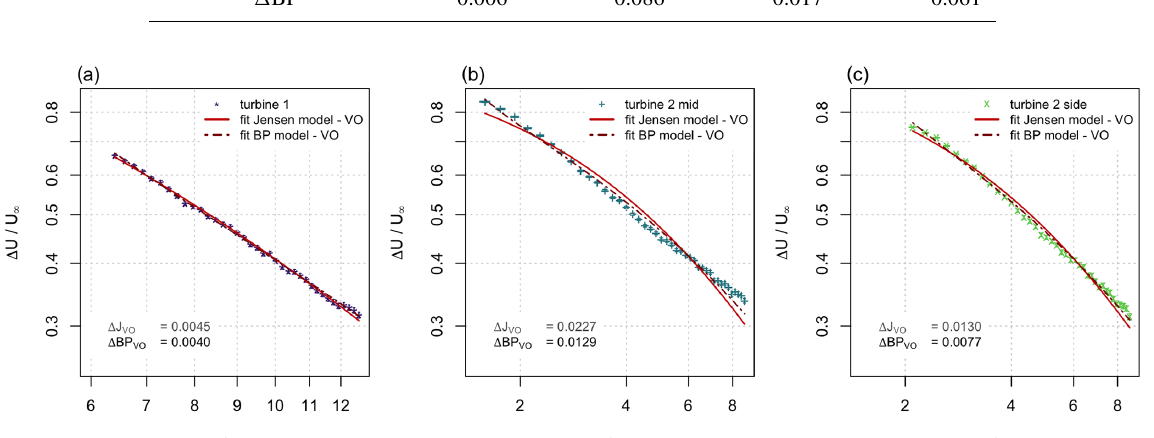
Figure 14. (cid:49)U/U ∞ for the three different inflow conditions at the centerline: (a) turbine 1 – laminar inflow, (b) turbine 2 mid – turbulent, and (c) turbine 2 side – turbulent and intermittent. The Jensen and the BP models are modified by including a virtual origin in the fits. Note that the axes are logarithmic.